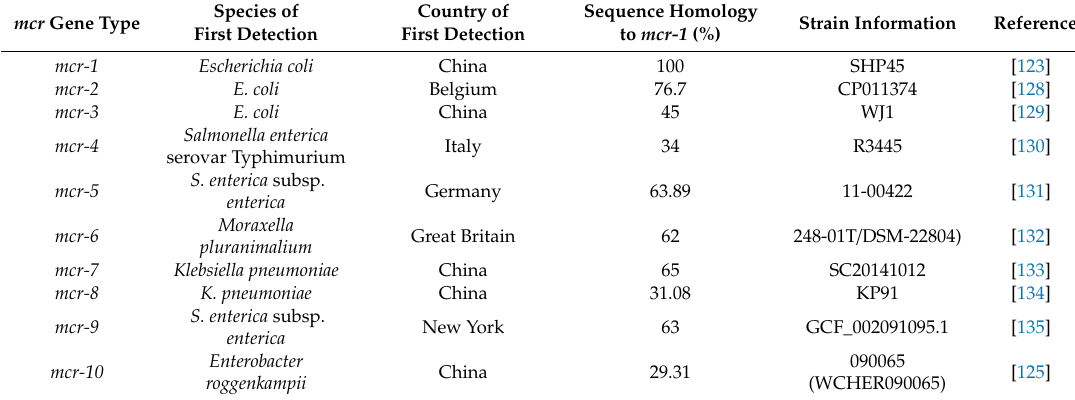
Table 2. The 10 discovered variants of the mobilized colistin resistance ( mcr ) gene, with their species and country of first detection, as well as their sequence homology to mcr-1